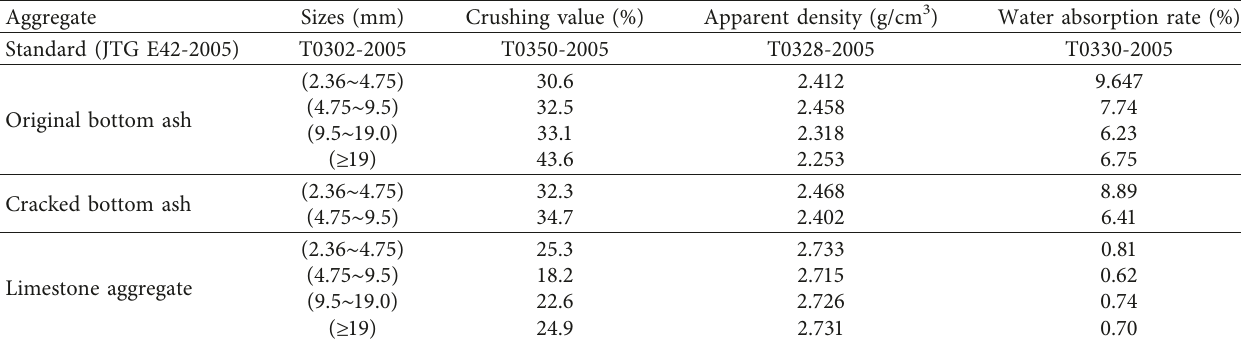
Table 2: Physical properties of aggregates.